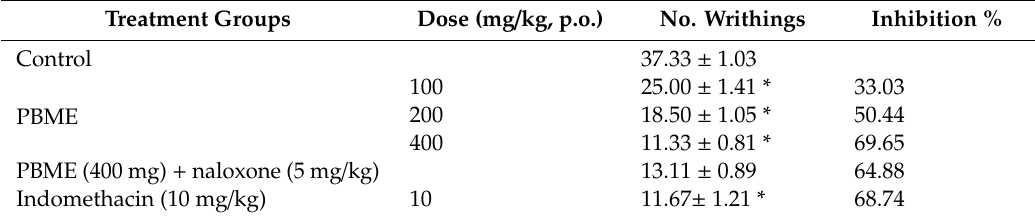
Table 1. Result of Pogostemon benghalensis leaves’ extracts on the acid-induced writhing reflex. Treatment Groups